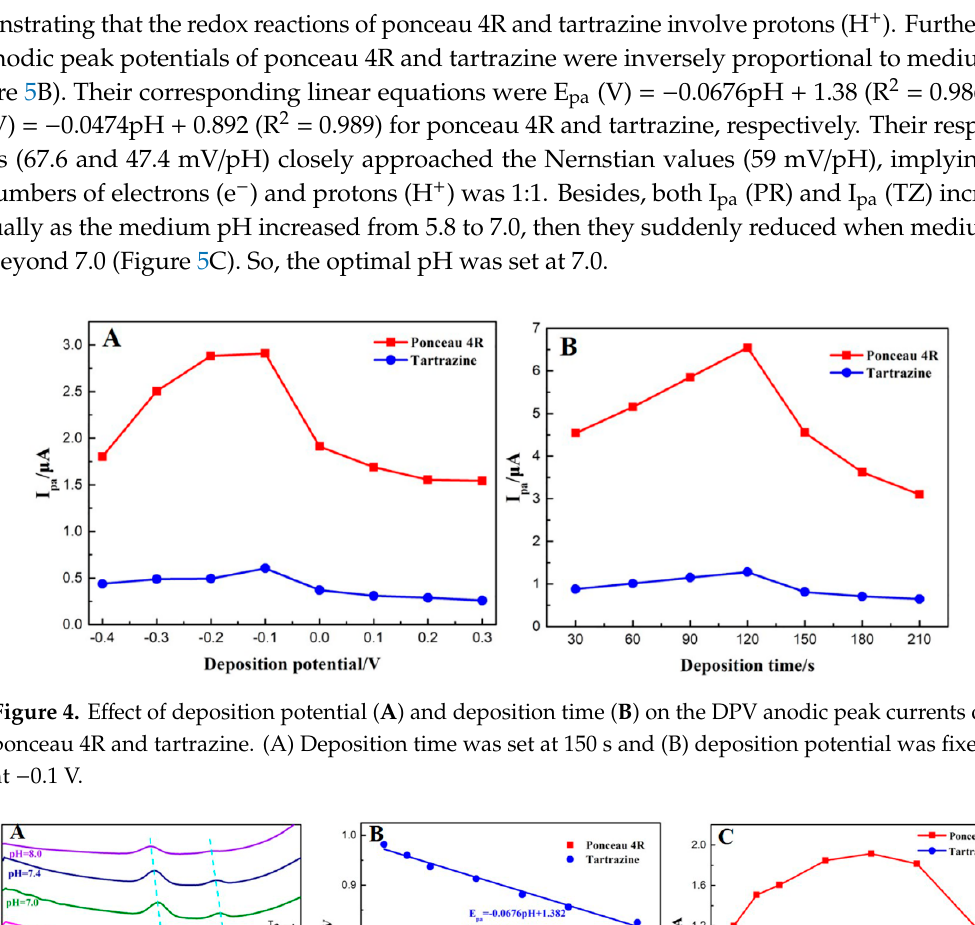
Figure 5. ( A ) DPV curves of ponceau 4R and tartrazine on TiO 2 /ErGO/GCE measured at different pH; ( B ) the dependence of anodic peak potential of ponceau 4R and tartrazine on pH and ( C ) the dependence of anodic peak current of ponceau 4R and tartrazine on pH. Deposition parameters: − 0.1 V, 120